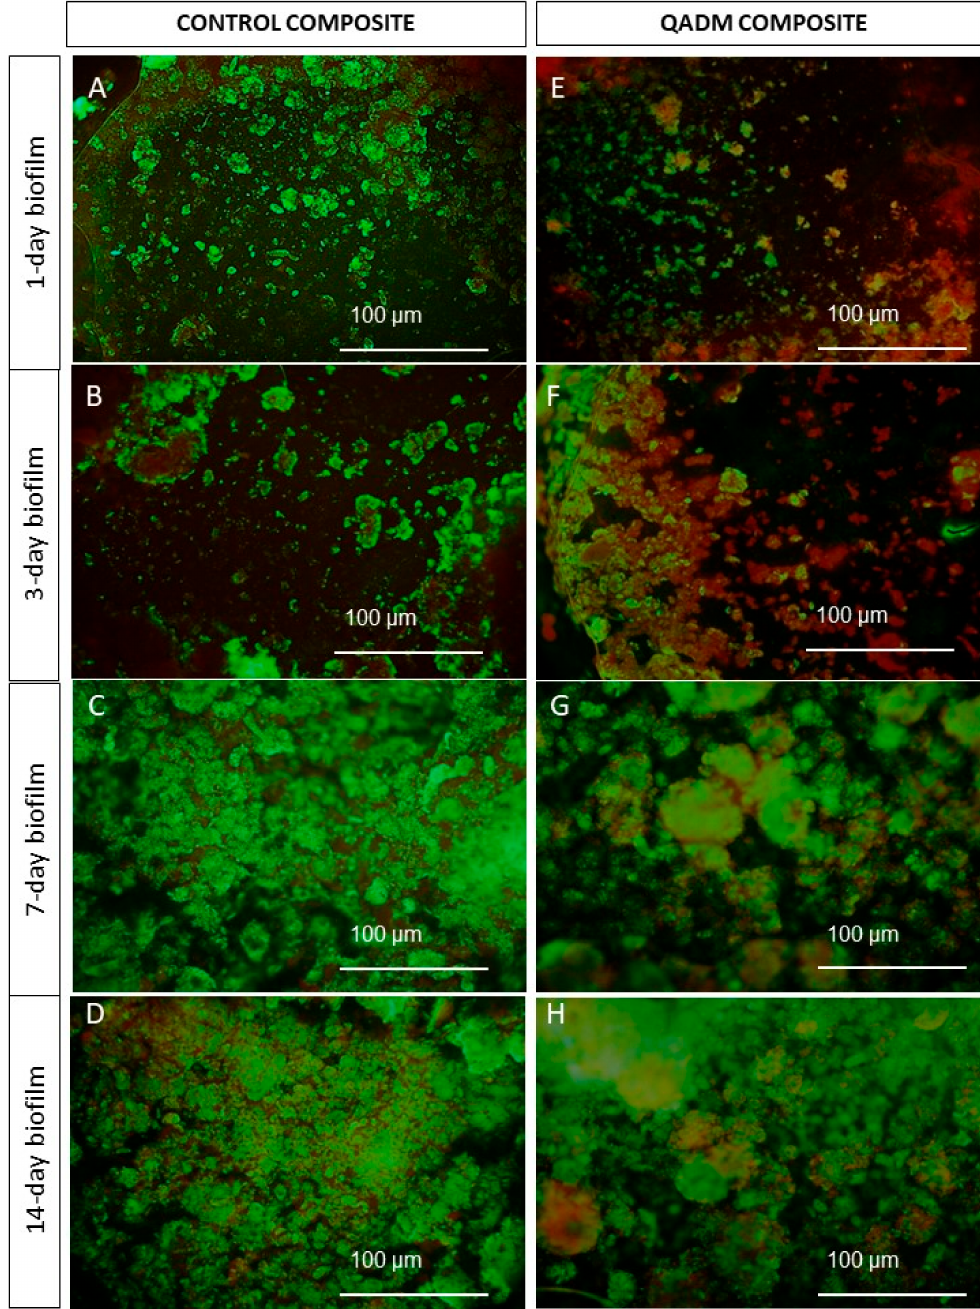
Figure 3. Live/dead staining images of biofilms grown on the QADM and control composites during the 1-, 3-, 7-, and 14-day periods. ( A , B ) Biofilms grown on the control composite on the 1st and 3rd days were primarily alive with continuous green staining. ( E , F ) Widespread cell-killing of bacteria was more pronounced on the 1- and 3-day biofilm accumulation on the QADM composite. On the 7th and 14th day, the overly mature biofilm structure was compact, with numerous layers presenting a mushroom-like configuration with channels in the outer layer: ( C , D ) for the control and ( G , H ) for the